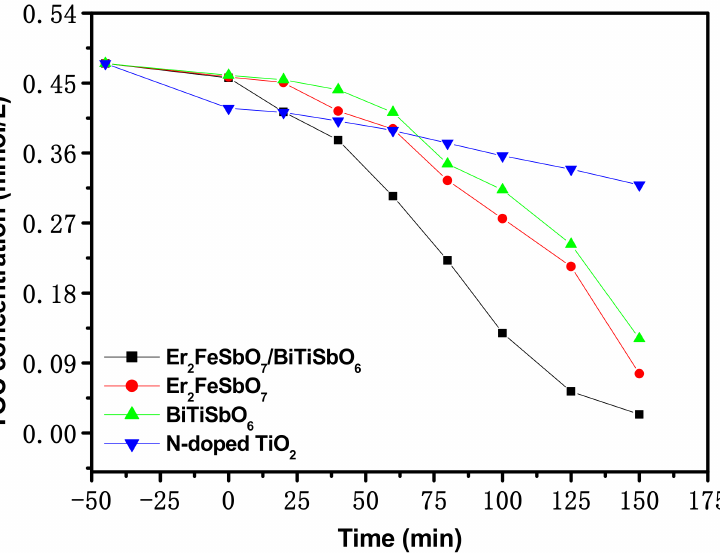
Figure 13. Concentration change curves of TOC during PCD of ENR in pharmaceutical waste water with EBH, Er 2 FeSbO 7 , BiTiSbO 6 or N-TO as photocatalyzer under VLGI.